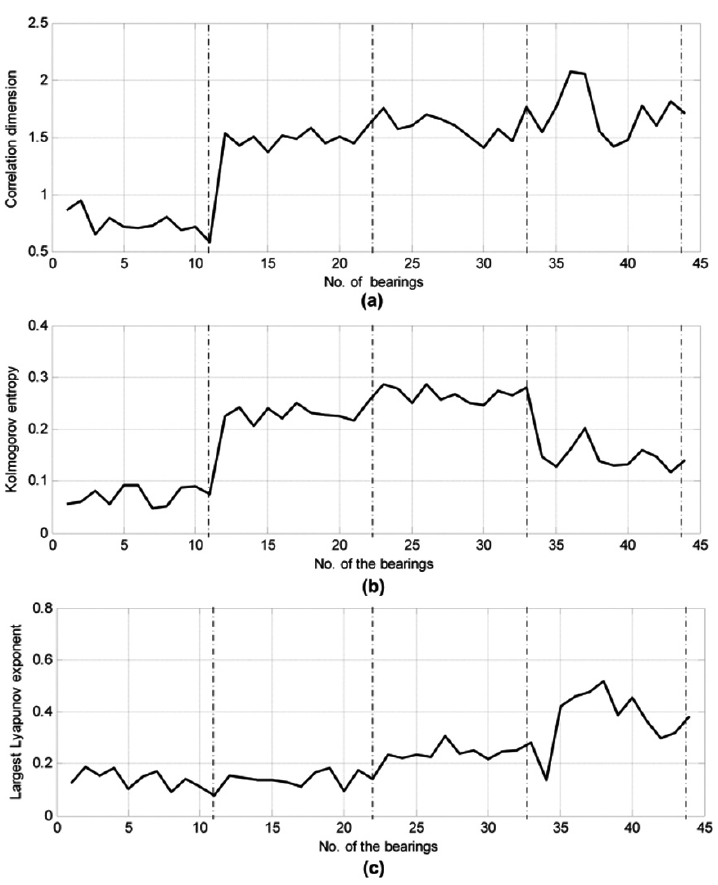
Fig. 8. Results of the three chaotic characteristic parameters (a) Correlation dimension (b) Kolmogorov entropy (c) Largest Lyapunov